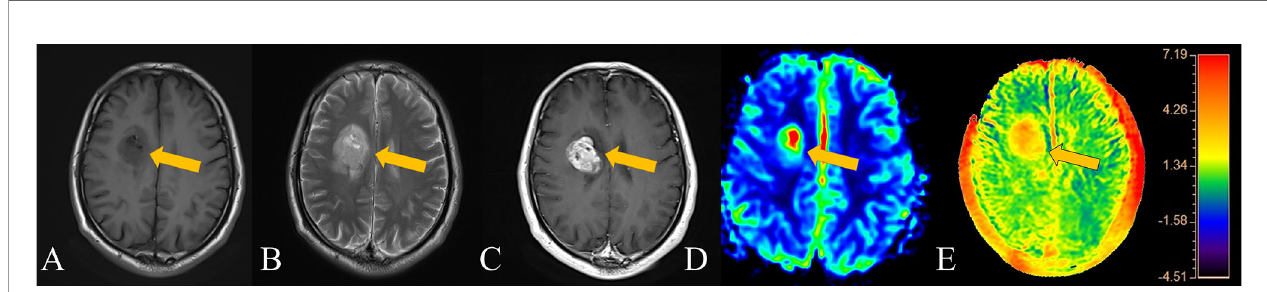
FIGURE 4 | Patient 3, a 62-year-old male, has an HGG in the right basal ganglia. The APT signal range of the patient was obviously larger than that on both T2WI and enhanced scans and larger than that on PWI. (A) T1-weighted imaging showed an iso-slightly low signal. (B) T2-weighted imaging showed an iso-slightly